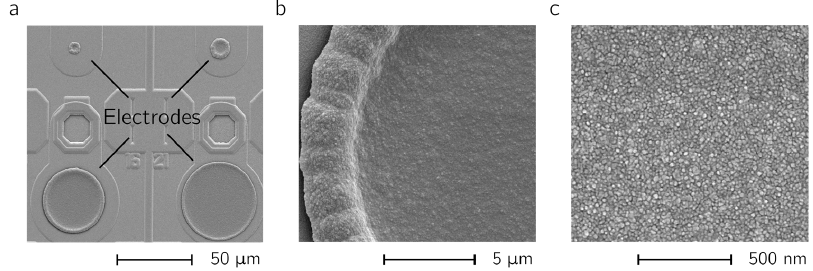
Figure 6. Deposited Poly(3,4-ethylenedioxythiophene) (PEDOT). ( a ) SEM micrographs of 5, 10, 40 and 50 µm diameter electrodes and ( b , c ) close-up views of a 25-µm-diameter electrode after PEDOT deposition.